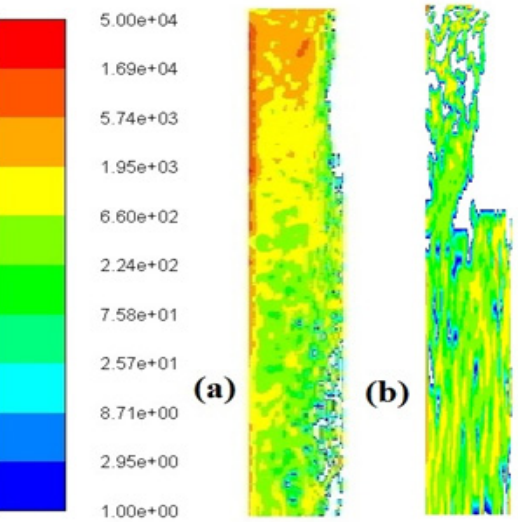
Table 12. Heat generated from the combustion of natural gas, heat loss from the walls, and per- centage heat loss.